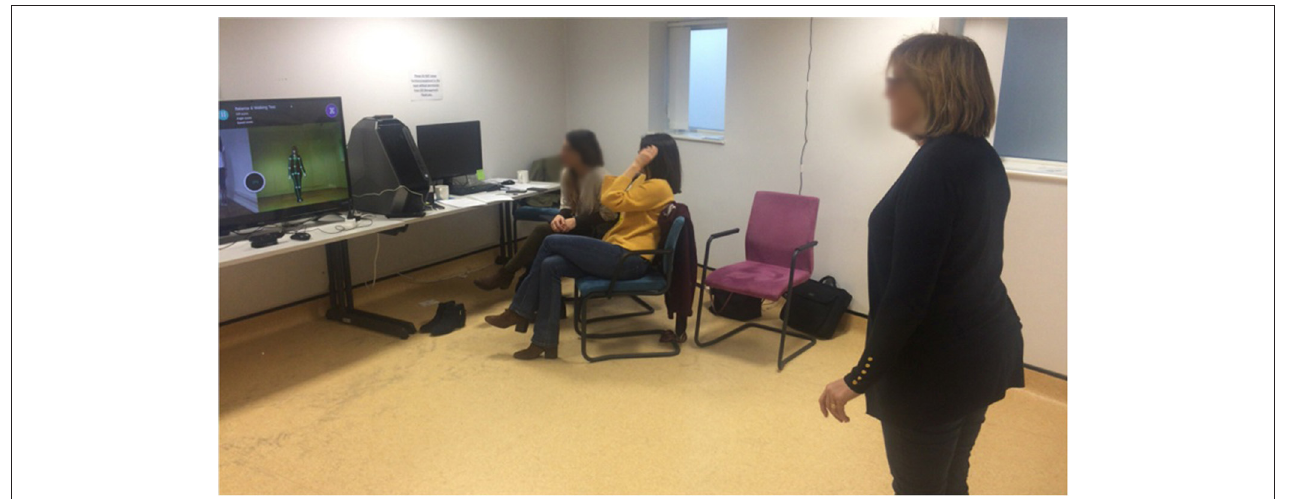
FIGURE 4 | The experimental setup of the Assessment Tests of the iPrognosis